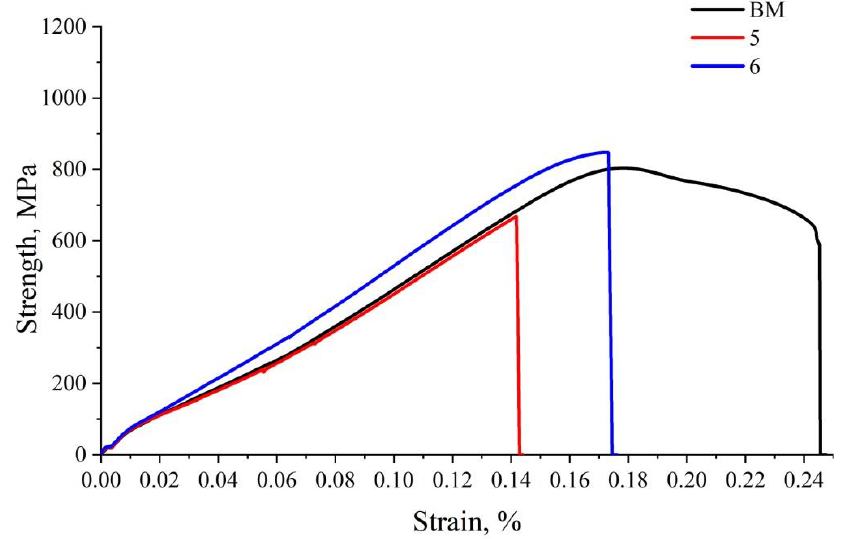
Figure 11. Stress – strain curves for Ti-4Al-3Mo-1V — Ti-6Al-4V welds obtained with different FSW parameters.